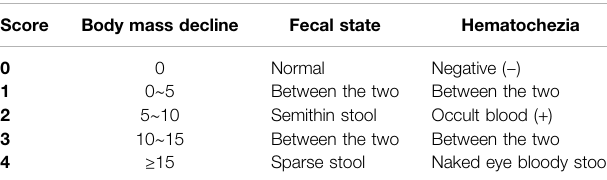
TABLE 1 | Disease activity index